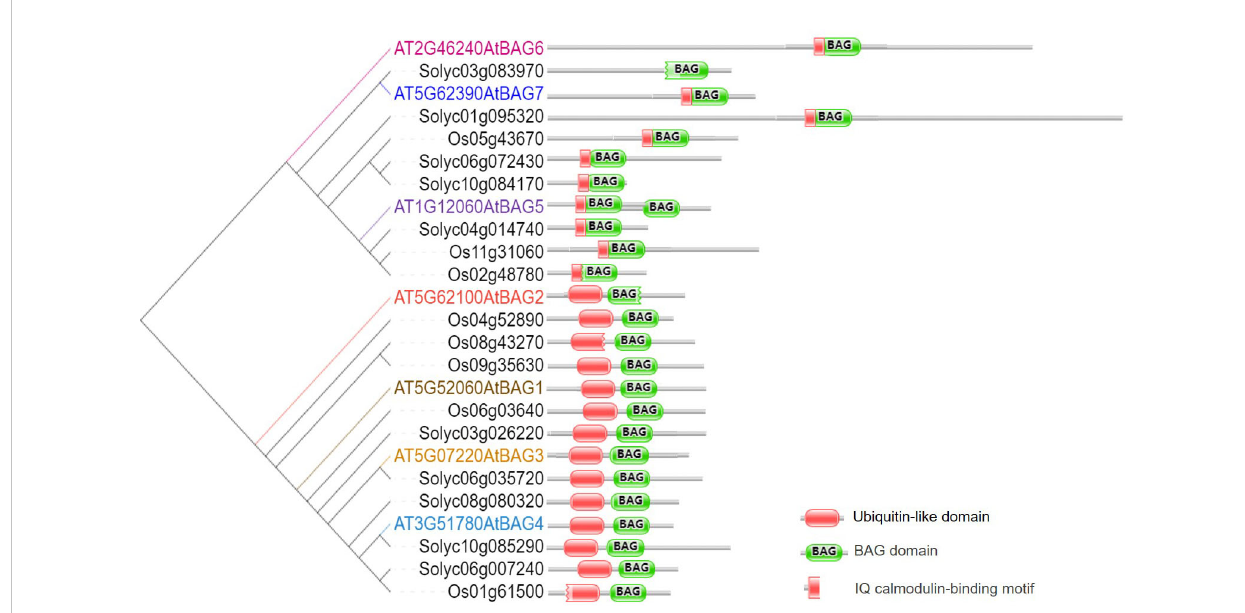
FIGURE 1 BAG domains of three plant species. Left: Phylogenetic tree of three plant species (At, Arabidopsis thaliana ; Sl, Solanum lycopersicum ; Os, Oryza sativa ). The protein sequences of these plant species were generated using the PhyML in MEGA 7.0. Based on the phylogenetic data, these proteins are classi fi ed into two distinct sub-groups. Right: BAG domains were generated through pfam (http://pfam.xfam.org/). The legends of BAG domain, Ubiquitin-like domain, and IQ motif are listed on the